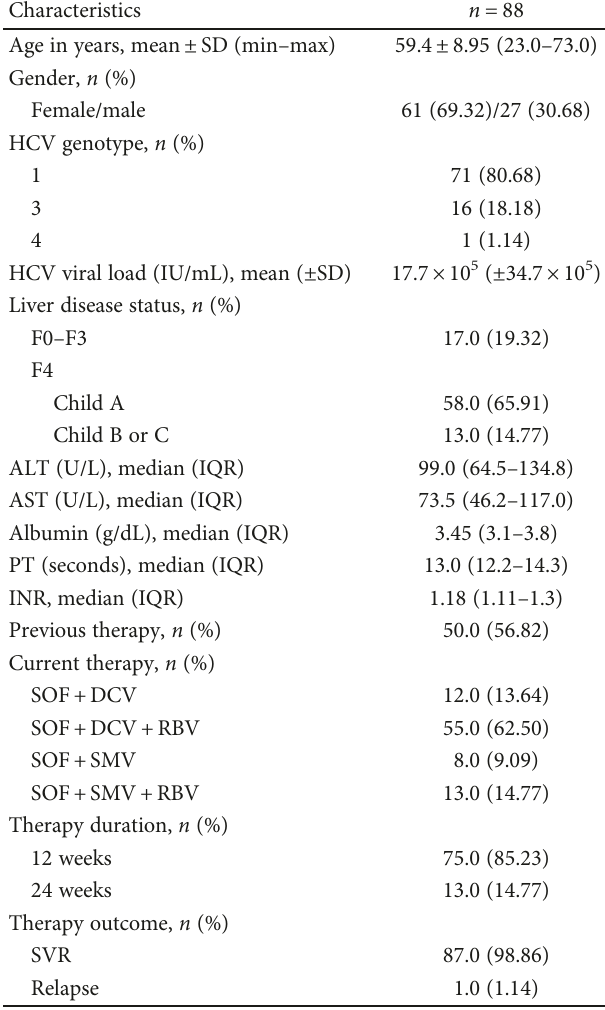
Table 1: Baseline demographic and clinical characteristics of chronic hepatitis C